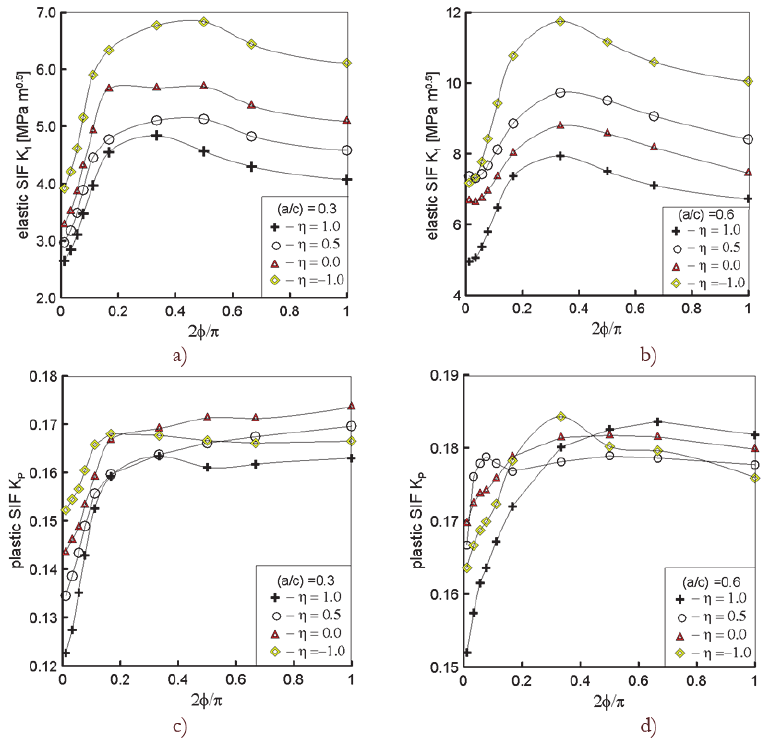
Figure 8: Elastic (a,b) and plastic (c,d) stress intensity factor behavior for different aspect ratio under biaxial